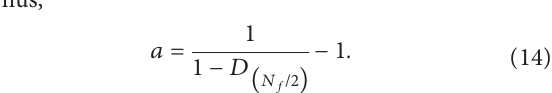
Figure 6: Fatigue curve of salt rock